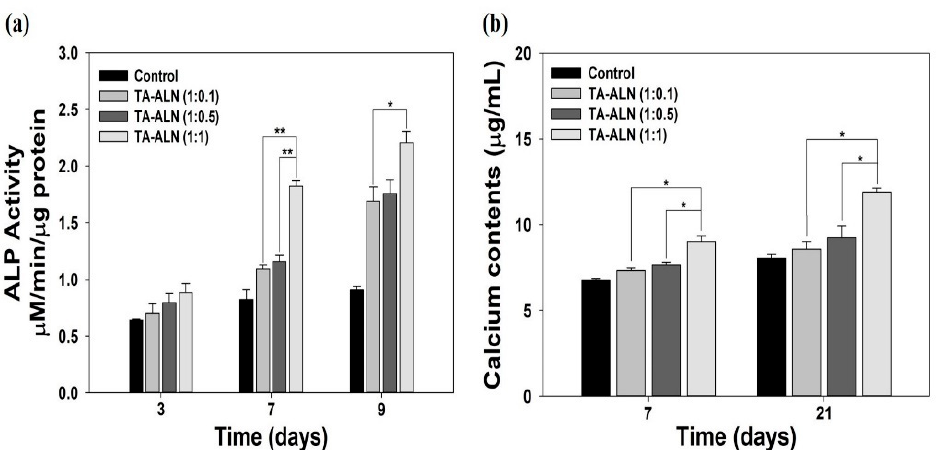
Figure 5. Early and late osteogenesis assessments. ( a ) ALP activity of MC3T3-E1 cells cultured with TA-ALN (1:0.1), TA-ALN (1:0.5), and TA-ALN (1:1) after 3, 7, and 9 days of culture. ( b ) Calcium accumulation in MC3T3-E1 cells cultivated with TA-ALN (1:0.1), TA-ALN (1:0.5) and TA-ALN (1:1) after 7 and 21 days. The p -value is a comparison between all TA-ALN types. * p < 0.05; ** p < 0.01; n = 4 per group.